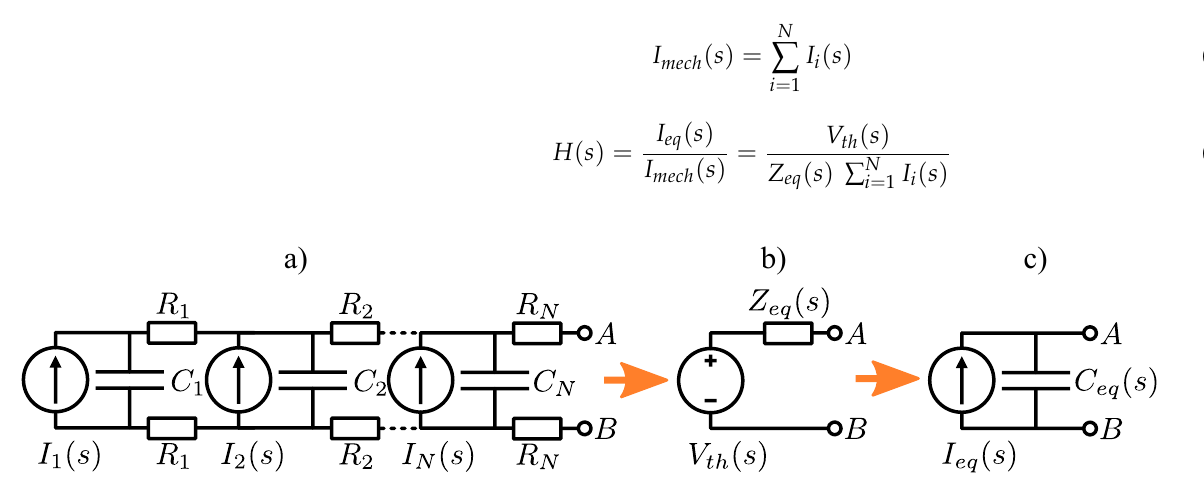
Figure 4. ( a ) The 1D PE sensor model with resistive electrodes. ( b ) PE sensor representation with Thevenin’s equivalent electric circuit. ( c ) PE sensor model with equivalent current source I eq and capacitance C eq